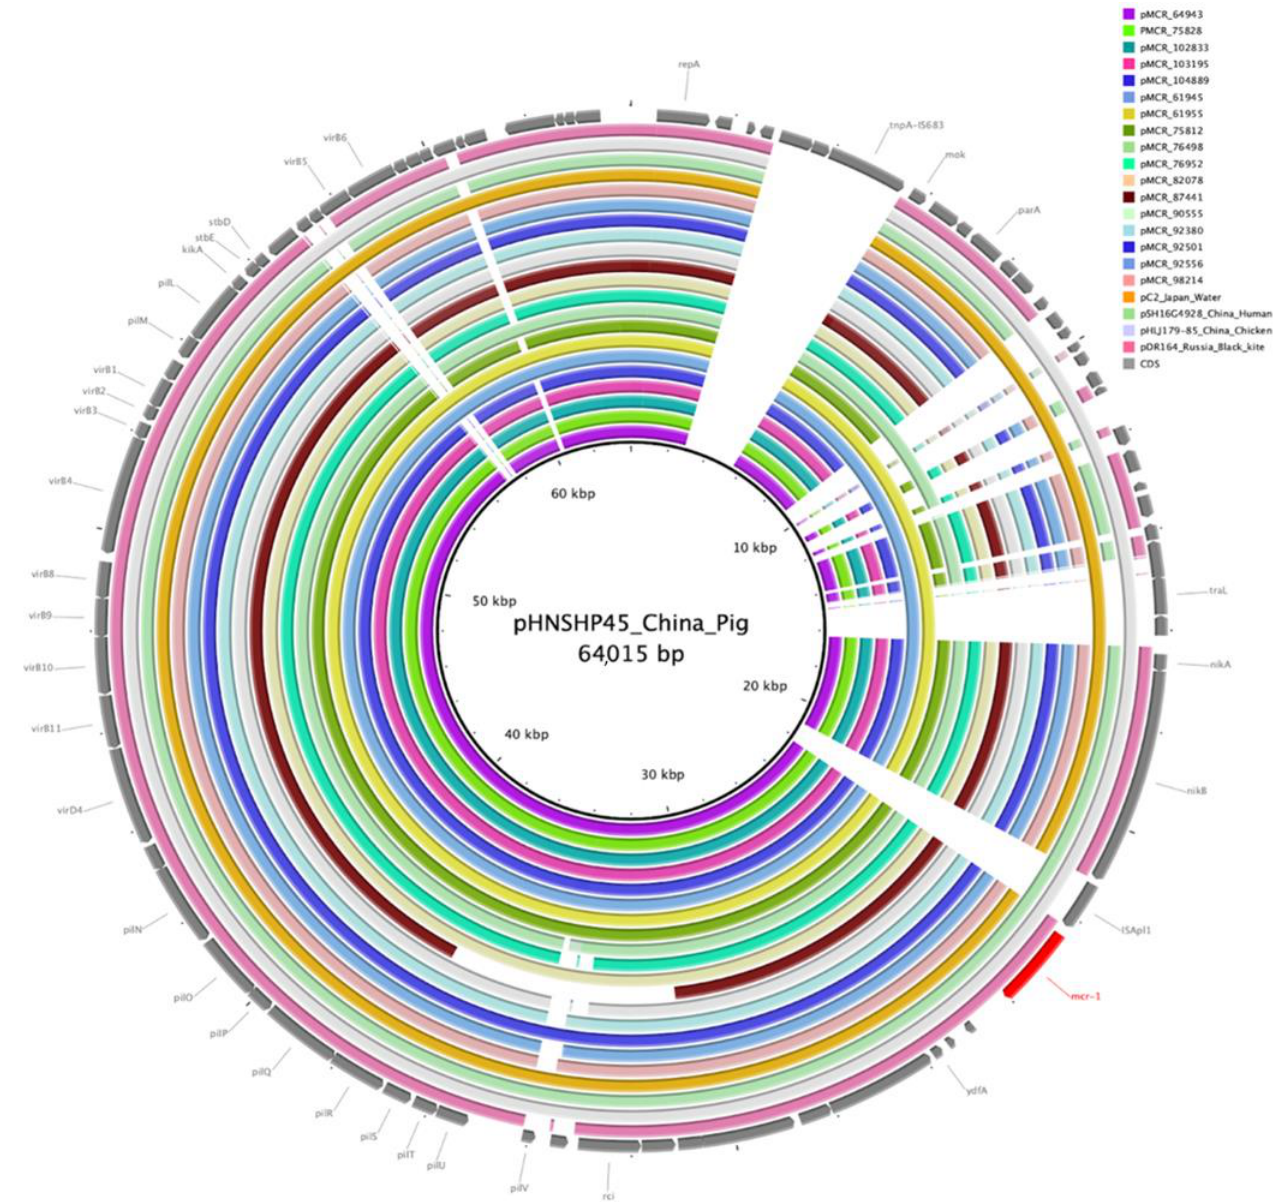
Figure 4. Sequence alignment of seventeen IncI2 mcr -bearing plasmids from this study and references from GenBank. The sequence of IncI2 plasmid pHNSHP45 (GenBank acc no. KP347127) was used as a reference (inner circle). The concentric circles show similar plasmids from this study and GenBank references and are colored according to legend. Gaps in the circles correspond to plasmid regions which are missing compared to the reference. The key plasmid genes and mcr-1.1 are shown in the outer circle with gray and red arrows.